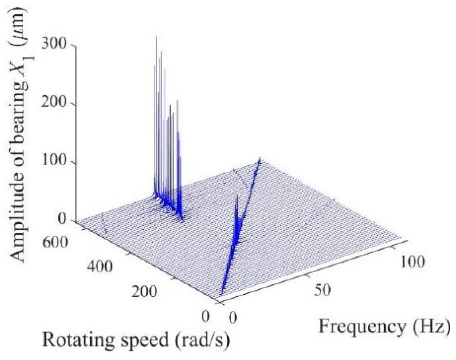
Figure 13. Trajectory of shaft center with the Poincaré map ( left side ) and the power spectrum ( right side ) for the rotating shaft at different rotating speeds.